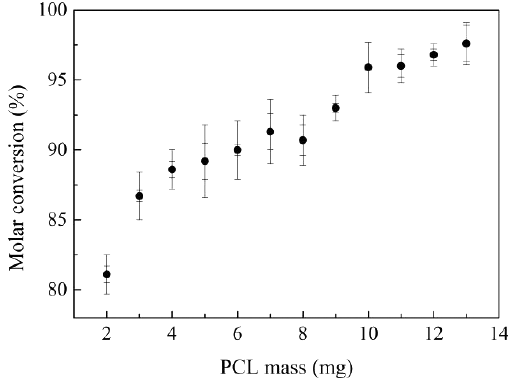
Figure 4: Molar conversion of hexanol reacting with vinyl acetate catalyzed by cotton-PCLs (10 mg cotton and 2-13 mg PCL).